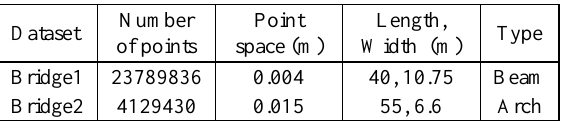
Table 2. Data used in this study. 4.2 Experimental Results of Point Cloud Segmentation